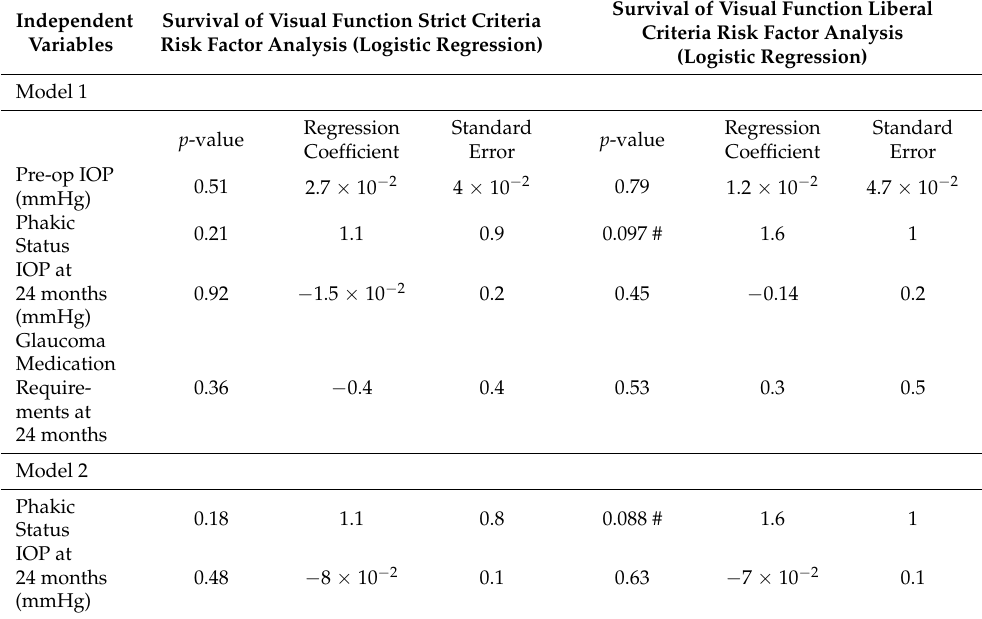
Table 4. Multivariate risk factor analysis. Two models of logistic regression including independent variables with p < 0.1 in the univariate